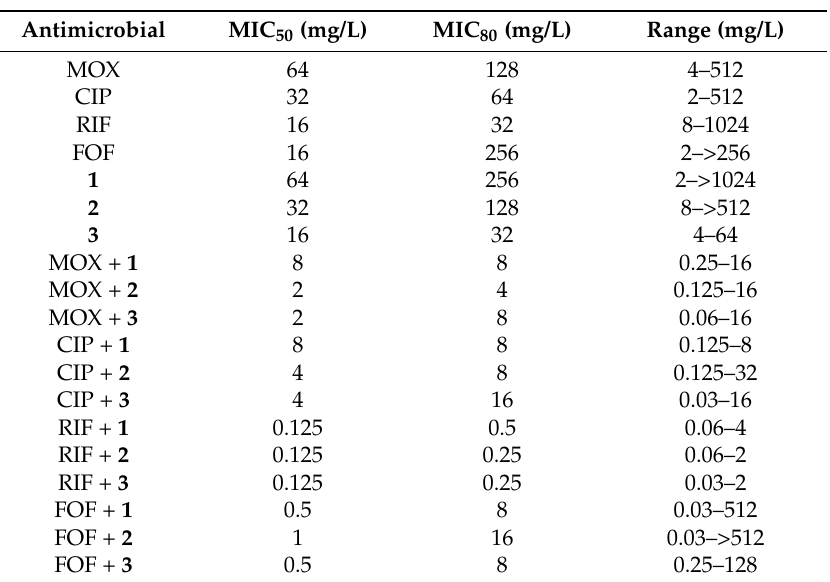
Table 3. In vitro activity of moxifloxacin (MOX), ciprofloxacin (CIP), rifampicin (RIF) and fosfomycin (FOF) alone or in combination with fixed concentration ( ≤ 8 mg/L (6.1–7.2 µ M)) of TOB-EPIs ( 1 , 2 , or 3 ) against MDR/XDR P. aeruginosa clinical isolates ( n = 8).